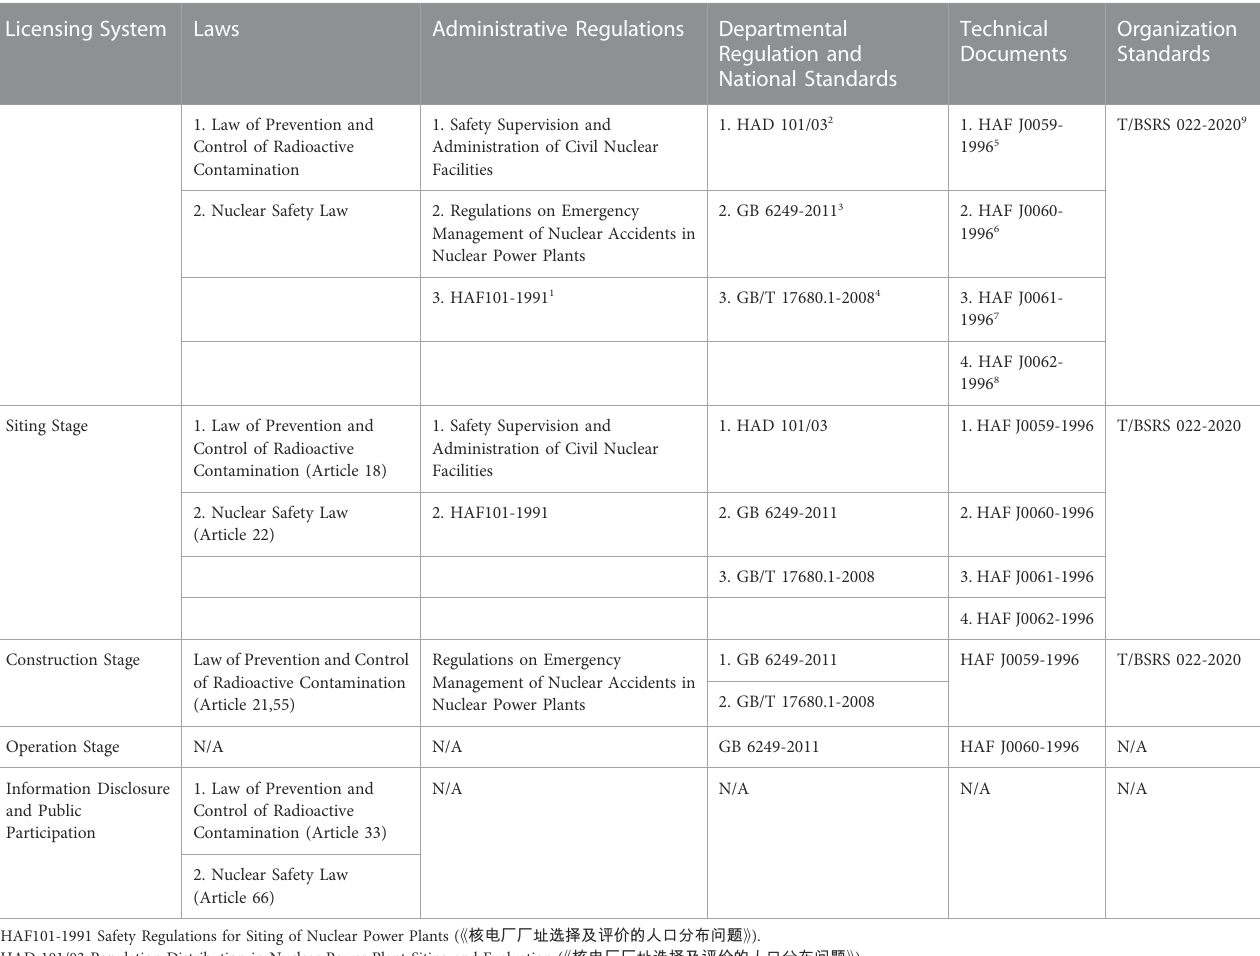
TABLE A1 China ’ s Licensing System of